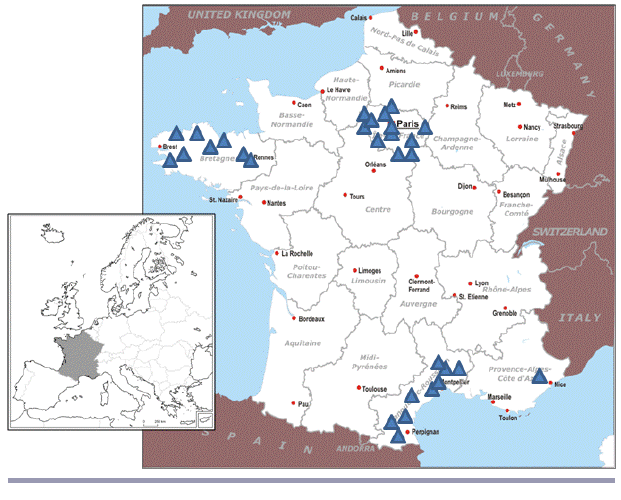
Fig. 1. Mapping of interviewees—France.